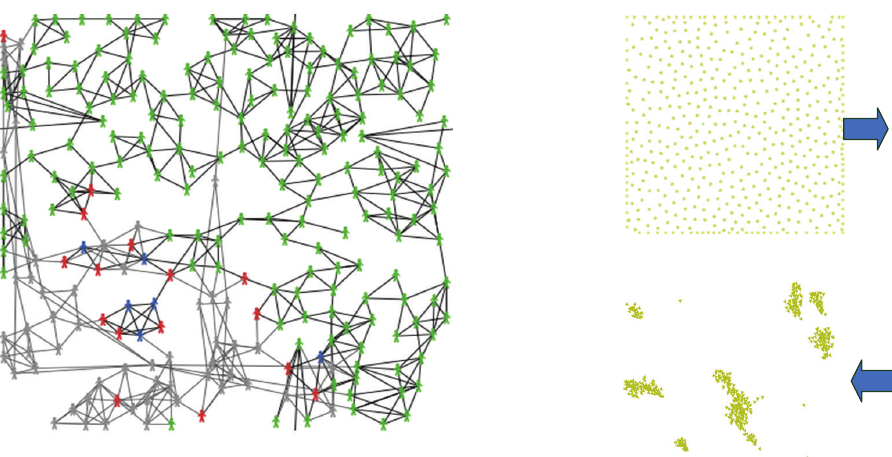
Figure 3: A snapshot of agents playing different roles (different colours) in the zombie-city model.